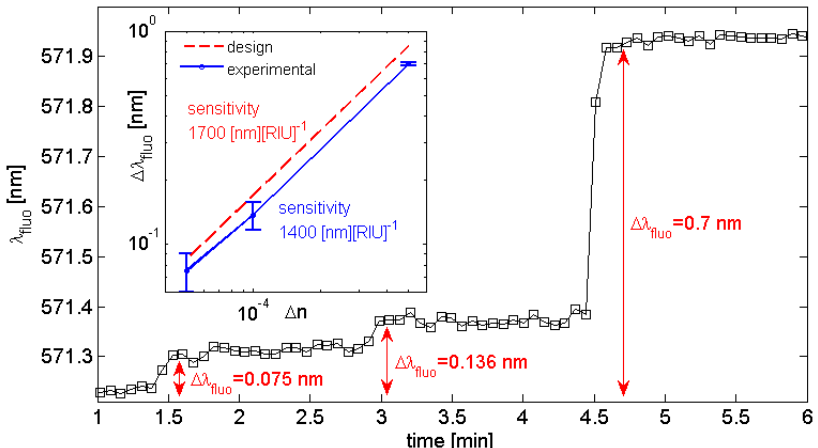
Figure 4. Spectral shift of BSW-coupled fluorescence upon injection of glucose solutions at different concentrations for the estimation of the sensitivity Δλ Inset: 1DPC sensitivity as experimentally estimated (blue solid line) and predicted from calculated design (red dashed